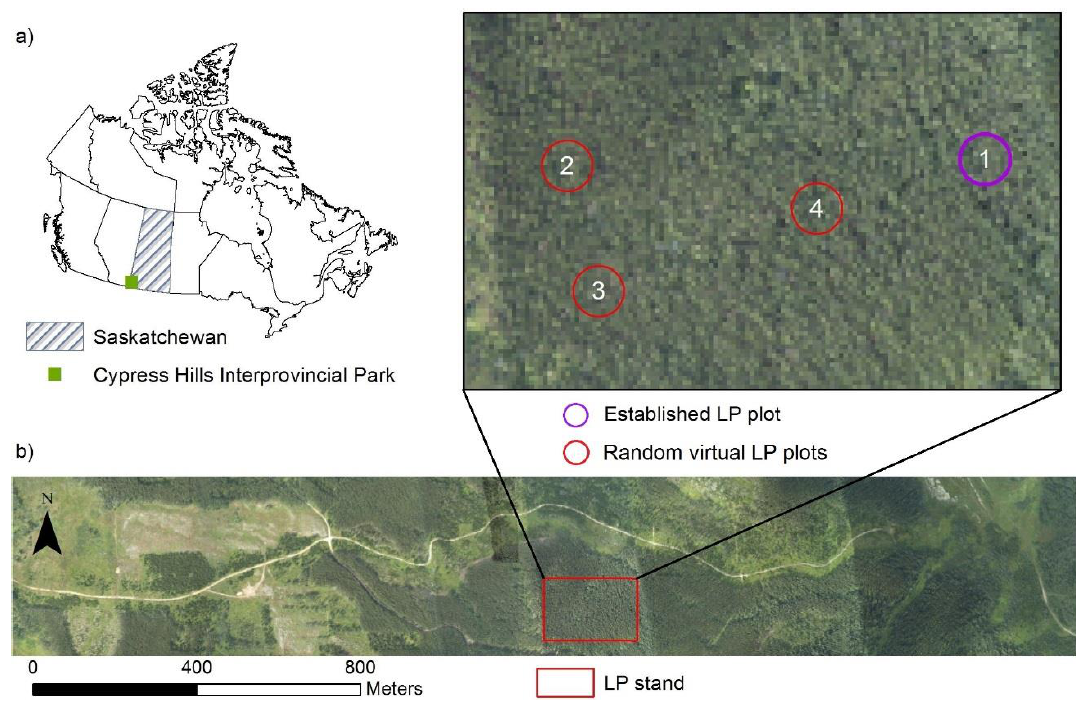
Figure 2. (a ) Map of Canada with highlighted Province of Saskatchewan and indicated Cypress Hills Interprovincial Park. ( b ) Area of interest (AOI) inside Cypress Hills Interprovincial Park colorized by RGB passive imagery. The lodgepole pine (LP) stand and plots (established and random virtual) are depicted inside the AOI.